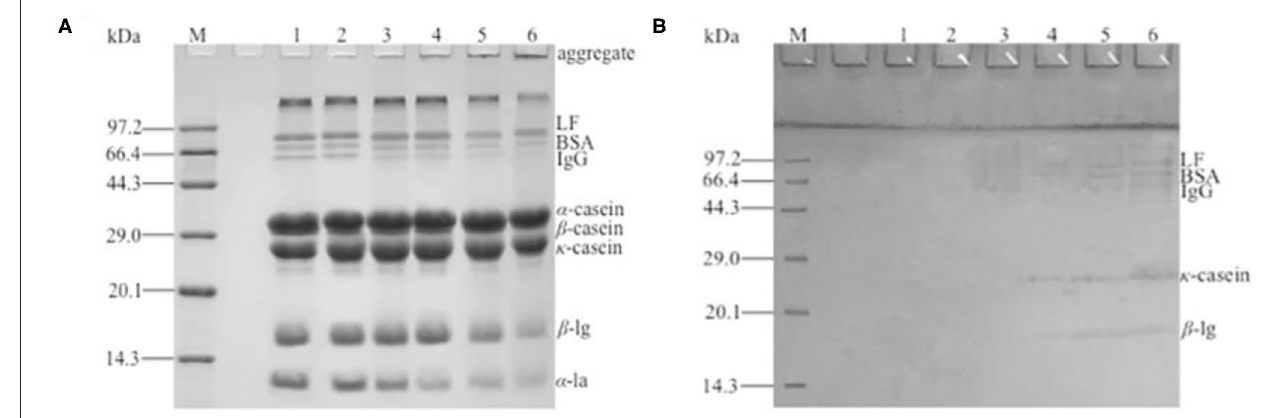
FIGURE 5 | Two-dimensional (2D) sodium dodecyl sulfate–polyacrylamide gel electrophoresis (SDS-PAGE) of different heat-treated skim milk. (A) Non-reduced SDS-PAGE of heat-treated samples; (B) reduced SDS-PAGE of protein aggregates excised from non-reduced gel. Lane M, protein marker; lane 1, skim milk without heat treatment; lanes 2–6, skim milk heat treatment at 55, 65, 75, 85, and 95 ◦ C,